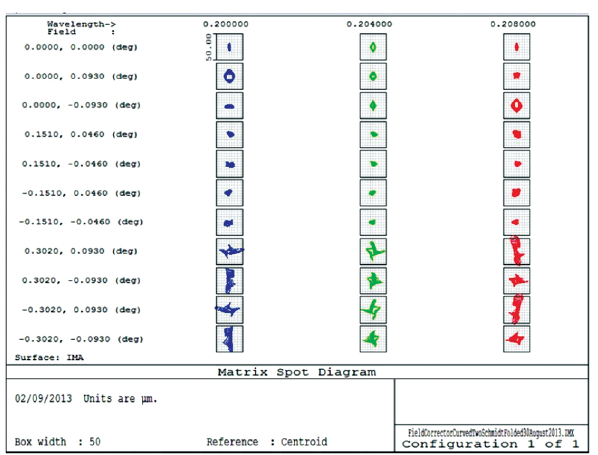
Figure 11: Optimization modeling of FIREBall with Zemax ray-tracing code . Spot diagram at the detector (box is 50 μ m). Wavelength range is (0.200 – 0.208 nm). FOV is (0 – 0.302 × 0 – 0.093 deg).